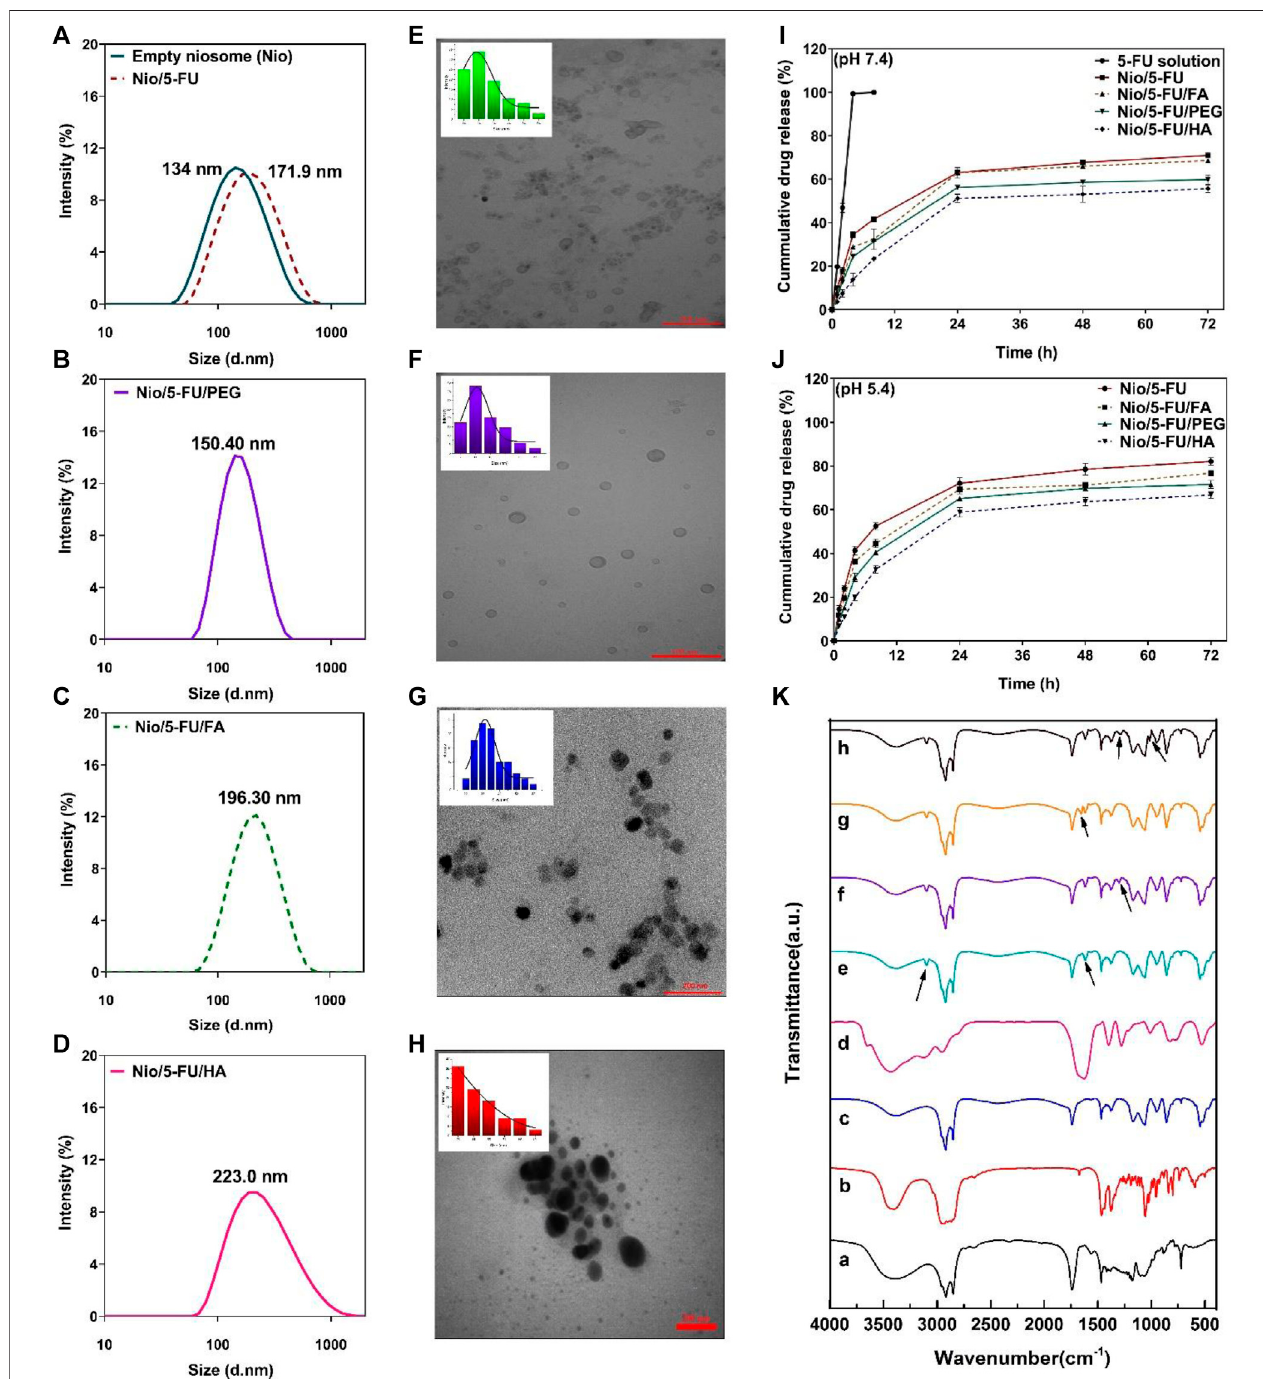
FIGURE4|(A – D) Theparticle sizeofsynthesized niosomesasdeterminedbydynamiclightscattering. (E) Transmissionelectron micrographand sizedistribution ofNio/5-FU. (F) TransmissionelectronmicrographandsizedistributionofNio/5-FU/PEG. (G) TransmissionelectronmicrographandsizedistributionofNio/5-FU/FA. (H) Transmission electron micrograph and size distribution of Nio/5-FU/HA. (I) In vitro release of 5-FU from different niosomal formulations at pH 7.4: 5-FU-loaded pristine niosomes (Nio/5-FU) and those that had been decorated with folic acid (FA), polyethylene glycol (PEG) or hyaluronic acid (HA). (Nio/5-FU/FA). (J) In vitro release of 5-UL fromdifferentniosomalformulationsatpH5.4. (K) Fouriertransform infrared FTIRspectraof a )Span 60, b )Cholesterol, c )niosome, d )5-FU, e ) Nio/5-FU, f )Nio/5- FU/PEG, g ) Nio/5-FU/HA, and h ) Nio/5-FU/FA.